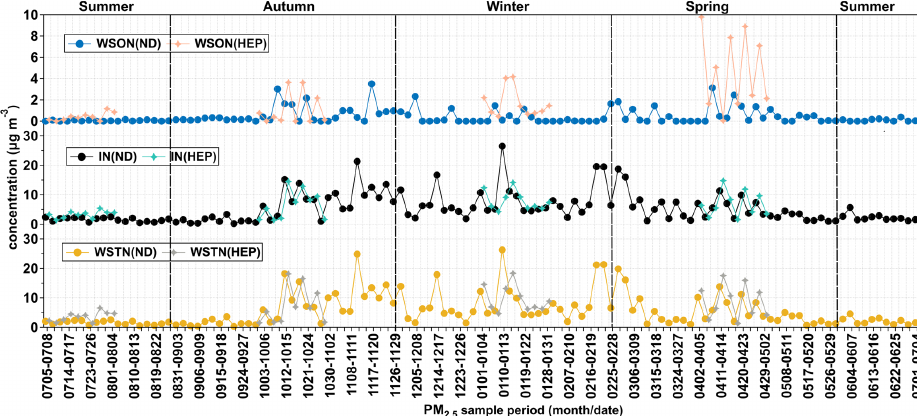
Figure 11. Temporal variations in WSTN, IN and WSON (µgm − 3 ) in PM 2 . 5 at ND (solid dots) and HEP (solid stars) in Tianjin during the campaign period